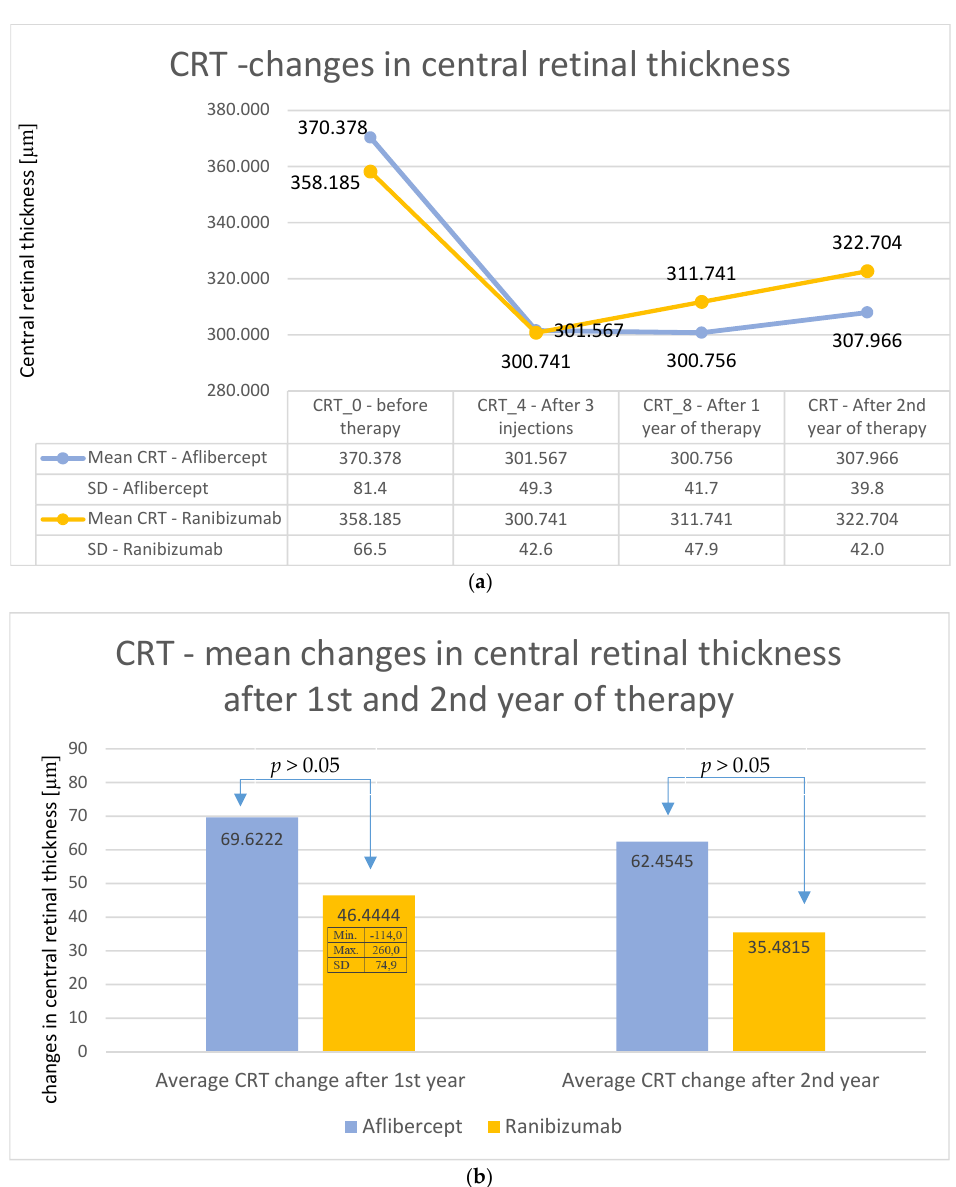
Figure 4. ( a ) Changes in the central retinal thickness during individual follow-up visits—comparison of treatment results for Aflibercept and Ranibizumab. The obtained decreases in retinal thickness did not differ significantly statistically between the two groups, ( p > 0.05). ( b ) Average change in central retinal thickness after the first and second years of treatment—comparison of treatment results for Aflibercept and Ranibizumab. No significant statistical differences ( p > 0.05) were observed.